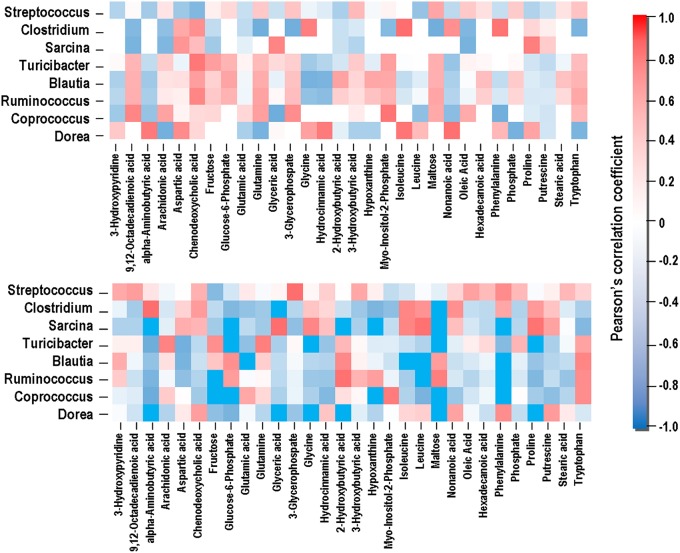
Correlation between the gut microbiome and metabolites. The color is according to the Pearson correlation coefficient distribution; red represents significant positive correlation (P < 0.05), blue represents significantly negative correlation (P < 0.05), and white represents that the correlation was not significant (P > 0.05).